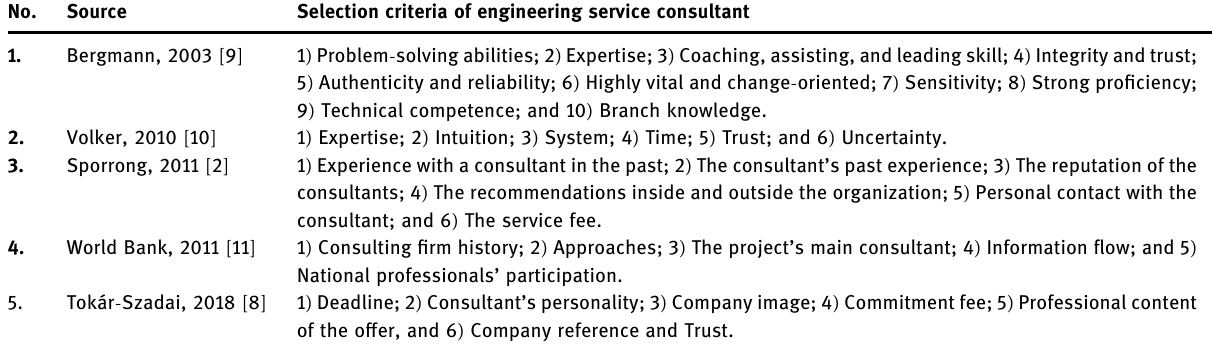
Table 1: The common selection criteria of engineering consultant from the relevant literature No. Source Selection criteria of engineering service